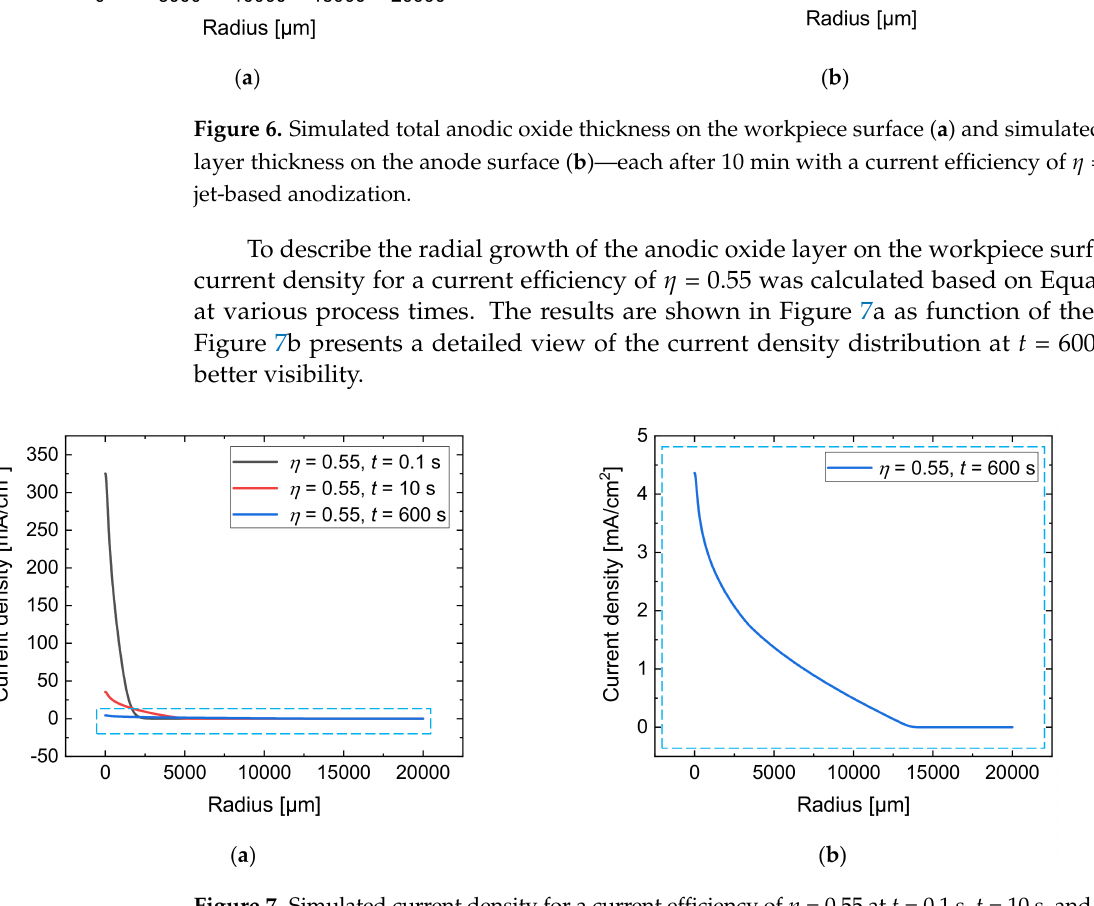
Figure 7. Simulated current density for a current efficiency of η = 0.55 at t = 0.1 s, t = 10 s, and t = 600 s ( a ); detailed view at t = 600 s ( b